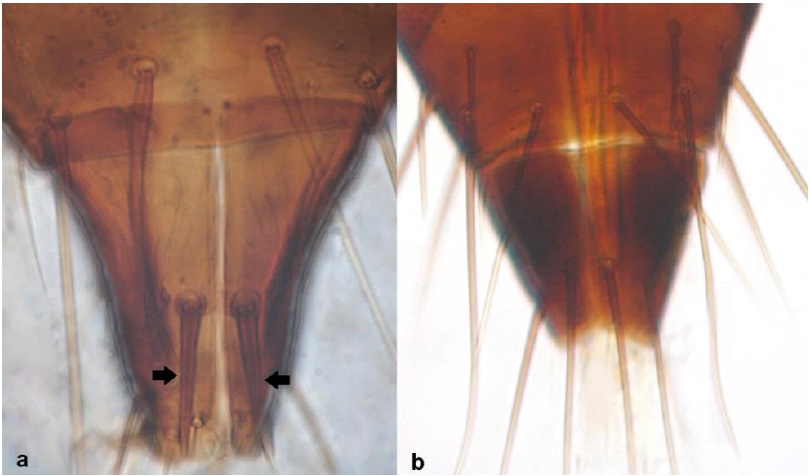
22 Abdominal segment X bearing a pair of thorn-shaped setae (Figure 22a)